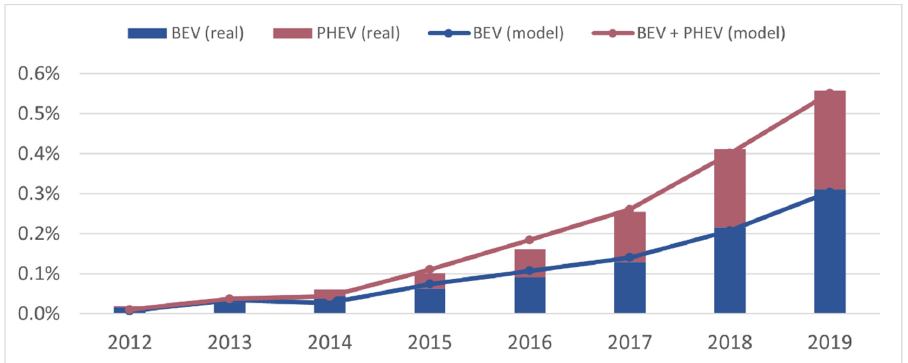
Figure 5. Comparison between the calibrated model and the real data. For the year 2019 a projection based on the October 2019 (cid:48) s vehicle stock was used, as the year has not ended to this date. (own figure based on data from the German Federal Motor Transport Authority [95] and the European Alternative Fuels Observatory